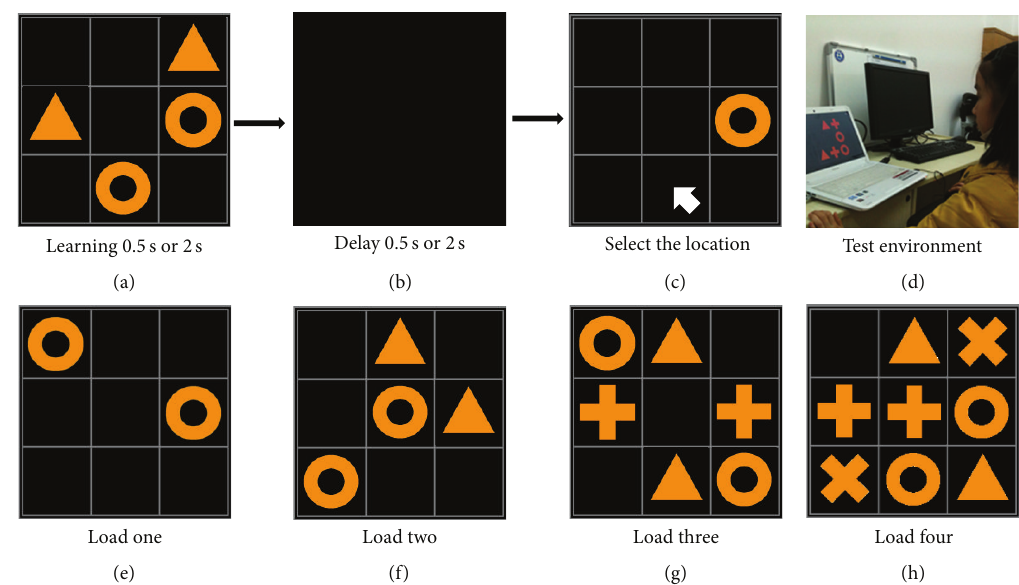
Figure 1: Example of a single trial and examples of 4 loads of difficulty. An example of a single trial ((a), (b), and (c)). The stimulus phase with learning time (Lt) of either 2 seconds or 0.5 seconds (a), the symbols then disappear during delay span ( 𝐷 ) for either 2 seconds or 0.5 seconds (b). After the delay span, the participant is prompted to select the location of the missing part of the symbol pair with the pointing device (c). (d) shows a participant taking the test. (e)–(h) show examples of the 4 loads of difficulty. Difficulty load 1 is not used in results and exists only to provide a short practice exercise for the subject prior to the administration of the real test. Loads 2 to 4 are used to produce test results, and illustrate the number of paired symbols in each